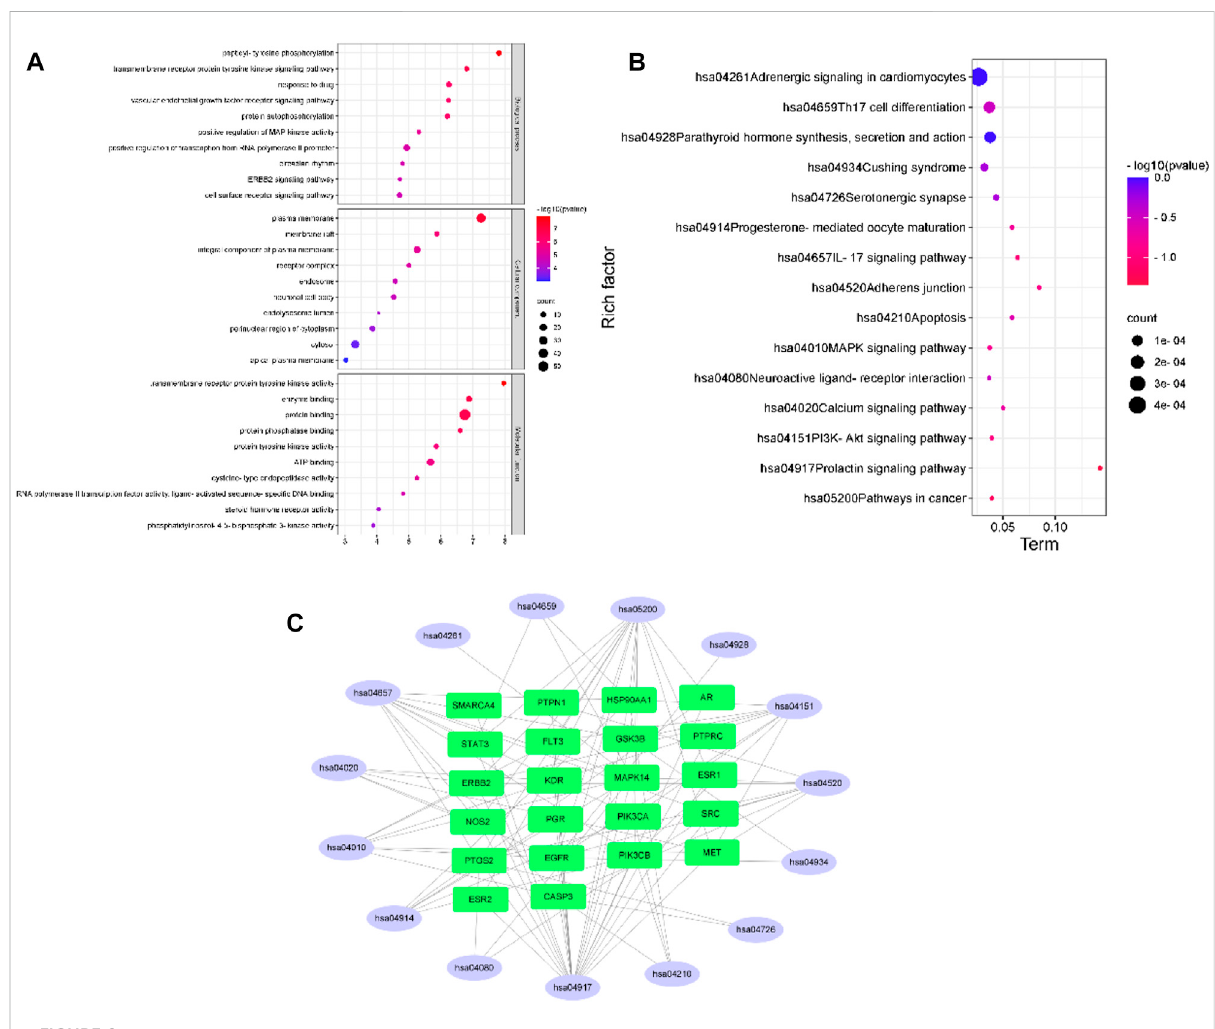
FIGURE 2 (A,B) GO and KEGG enrichment analysis (C) and pathway-target network.